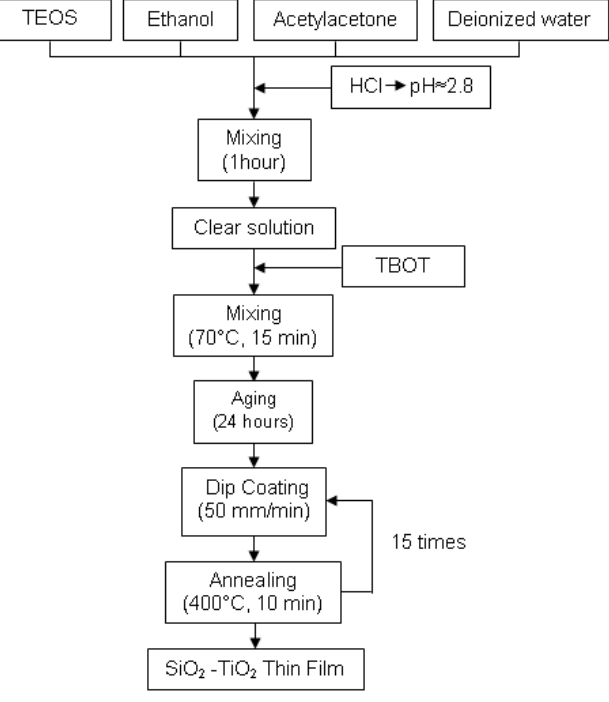
Figure 1. Flowchart of SiO